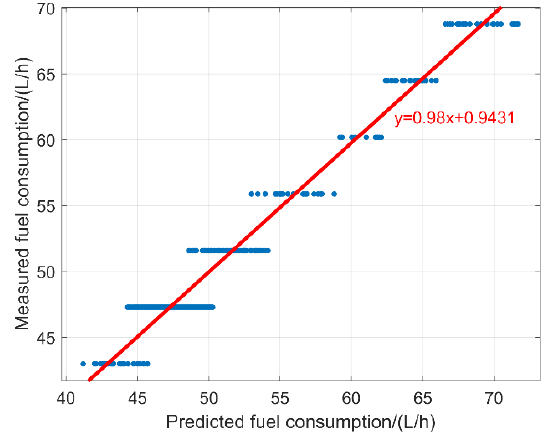
Figure 9. Relationship between predicted and actual fuel consumption values ( The blue line shows the relationship between the predicted value and the actual value, and the red line is the line to further fit the predicted value and the actual value).